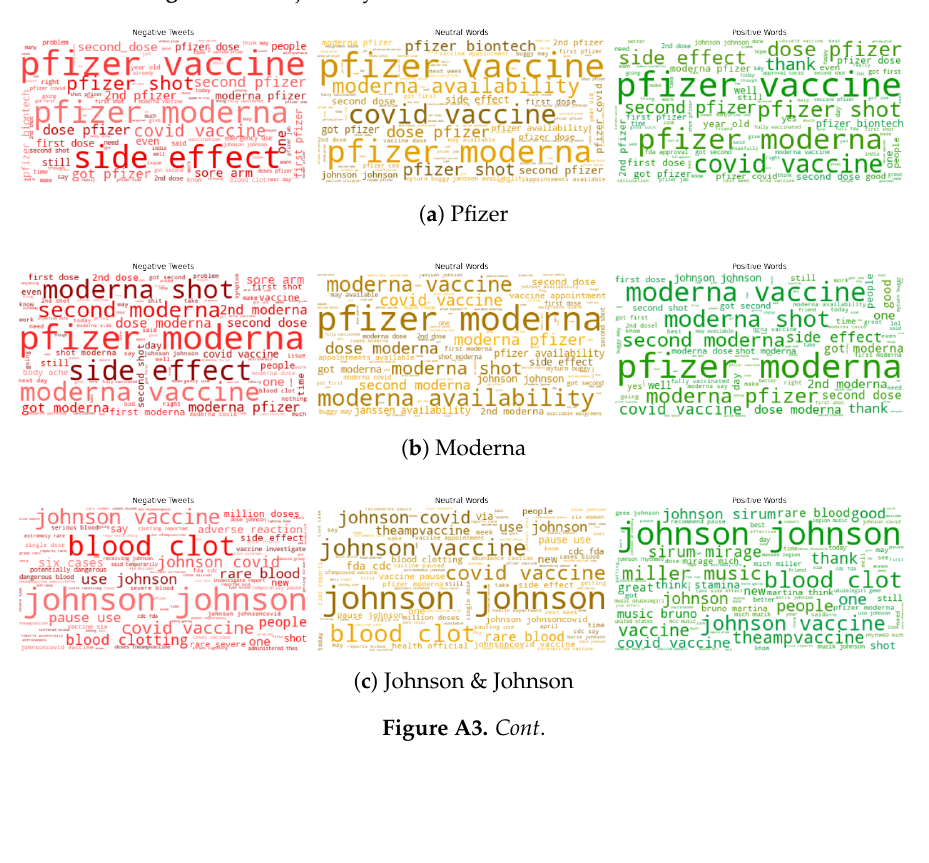
Figure A2. Subjectivity Score of sentiment for different vaccines.